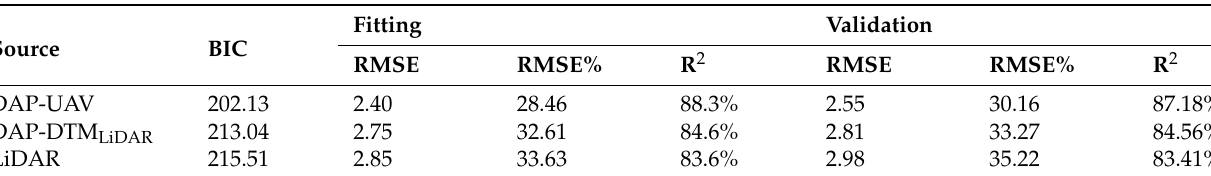
Table 13. Fitting and validation statistics of the best models for estimating basal area from DAP-UAV, DAP-DTM LiDAR , and LiDAR.